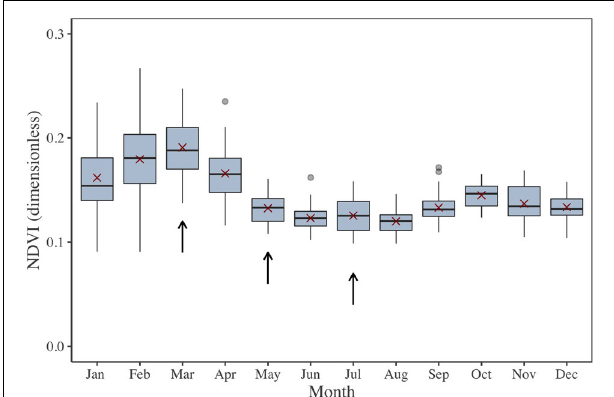
FIGURE 2 | NDVI 2000–2015 time series illustrating the MPB biomass seasonal cycle for the Brouage mudflat. NDVI was retrieved from Terra MODIS reflectance. Box plots were calculated for each month. The red crosses are the monthly average. Arrows show the three period of investigation (March, May, and